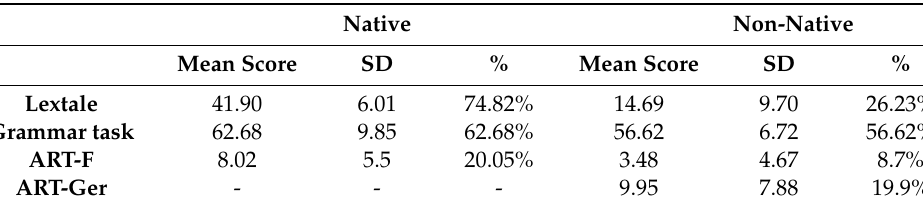
Table 2. Mean scores of the Lextale, the French author recognition task (ART-F), the German author recognition task (ART-Ger) and grammar tasks by native and non-native speakers.